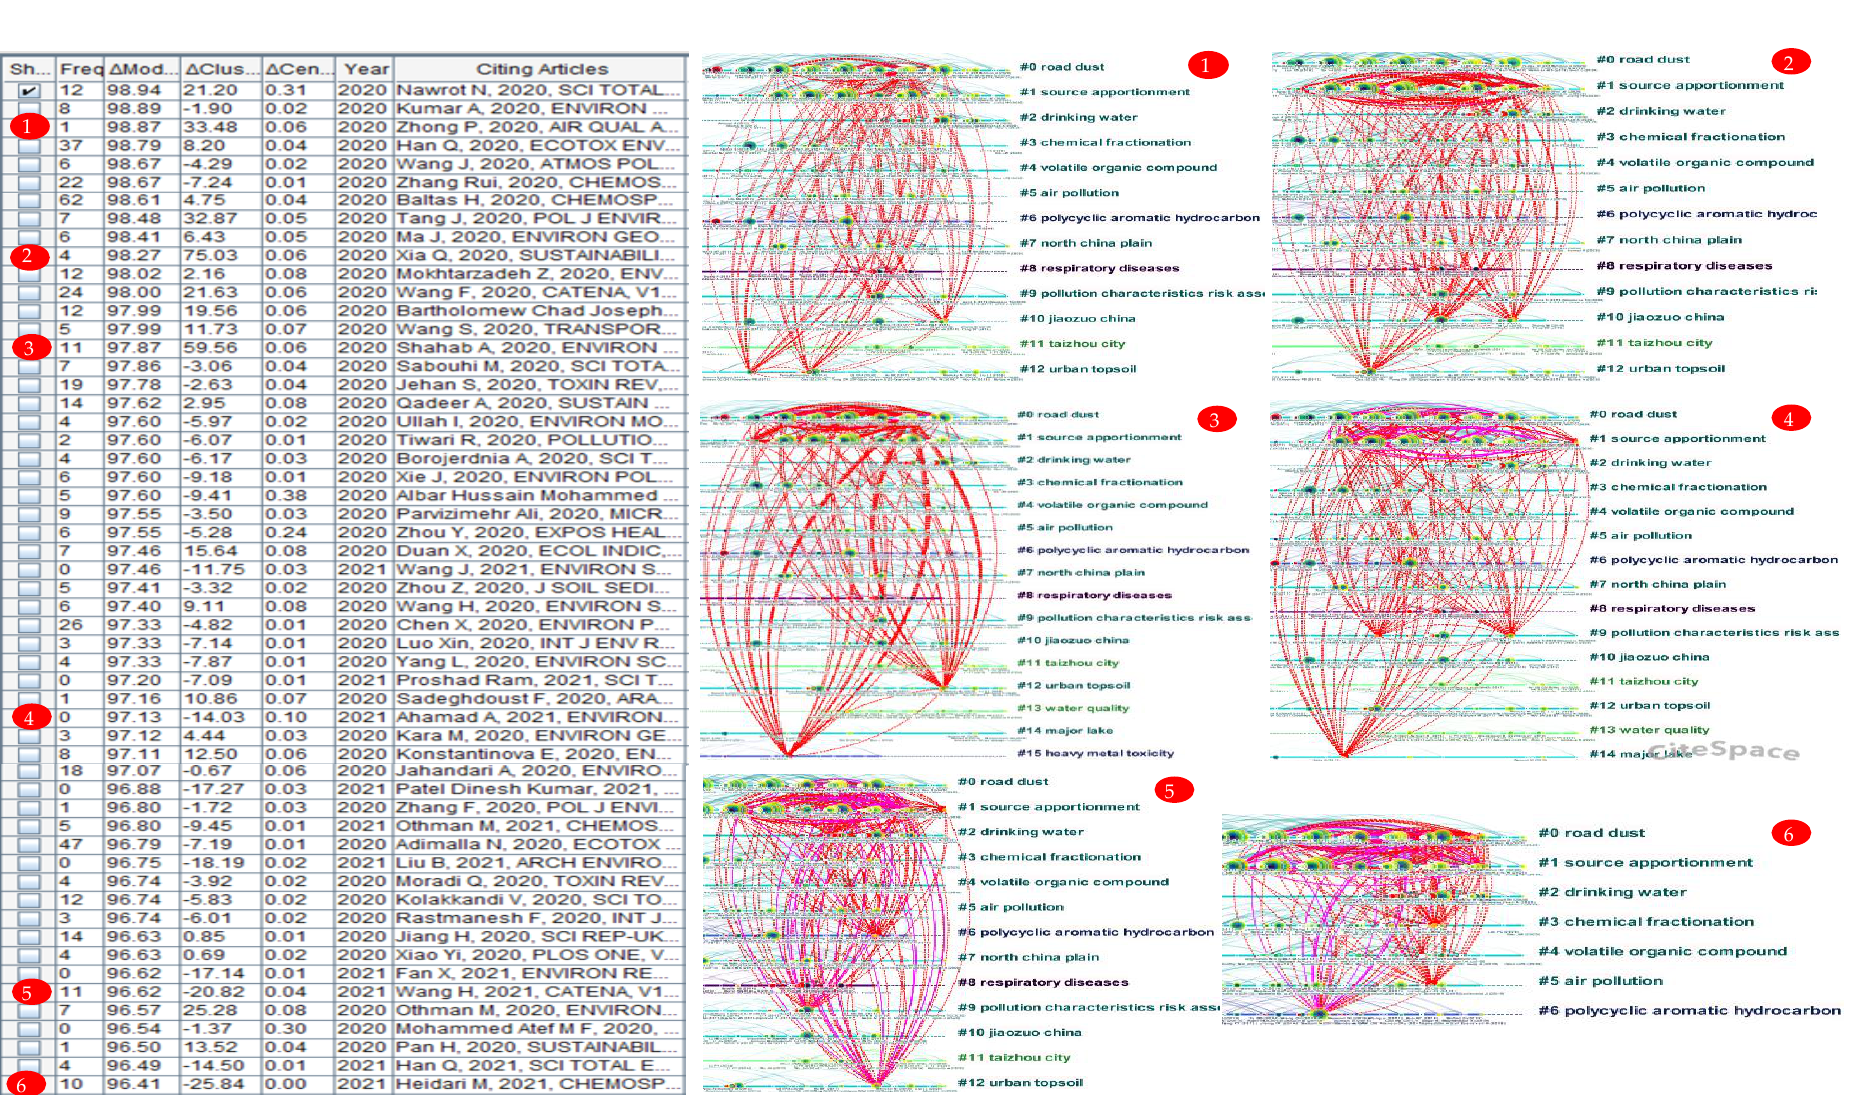
Figure 10. Six examples of articles with high modularity change rates .